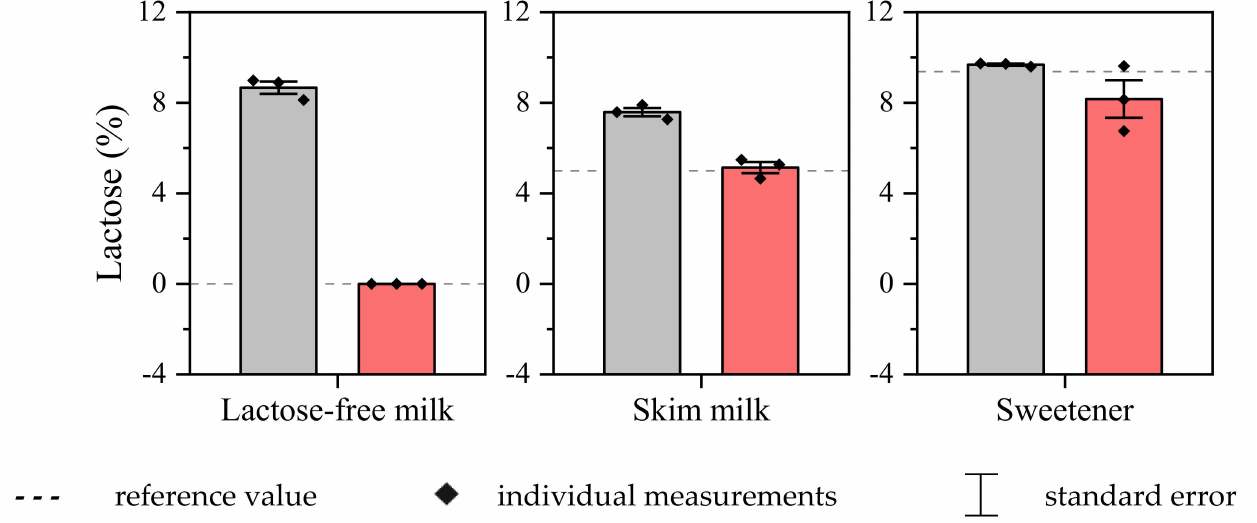
Figure 6. Results obtained for lactose analysis in commercial food products using the photoelectro- chemical (red bars) and spectrometric (gray bars)